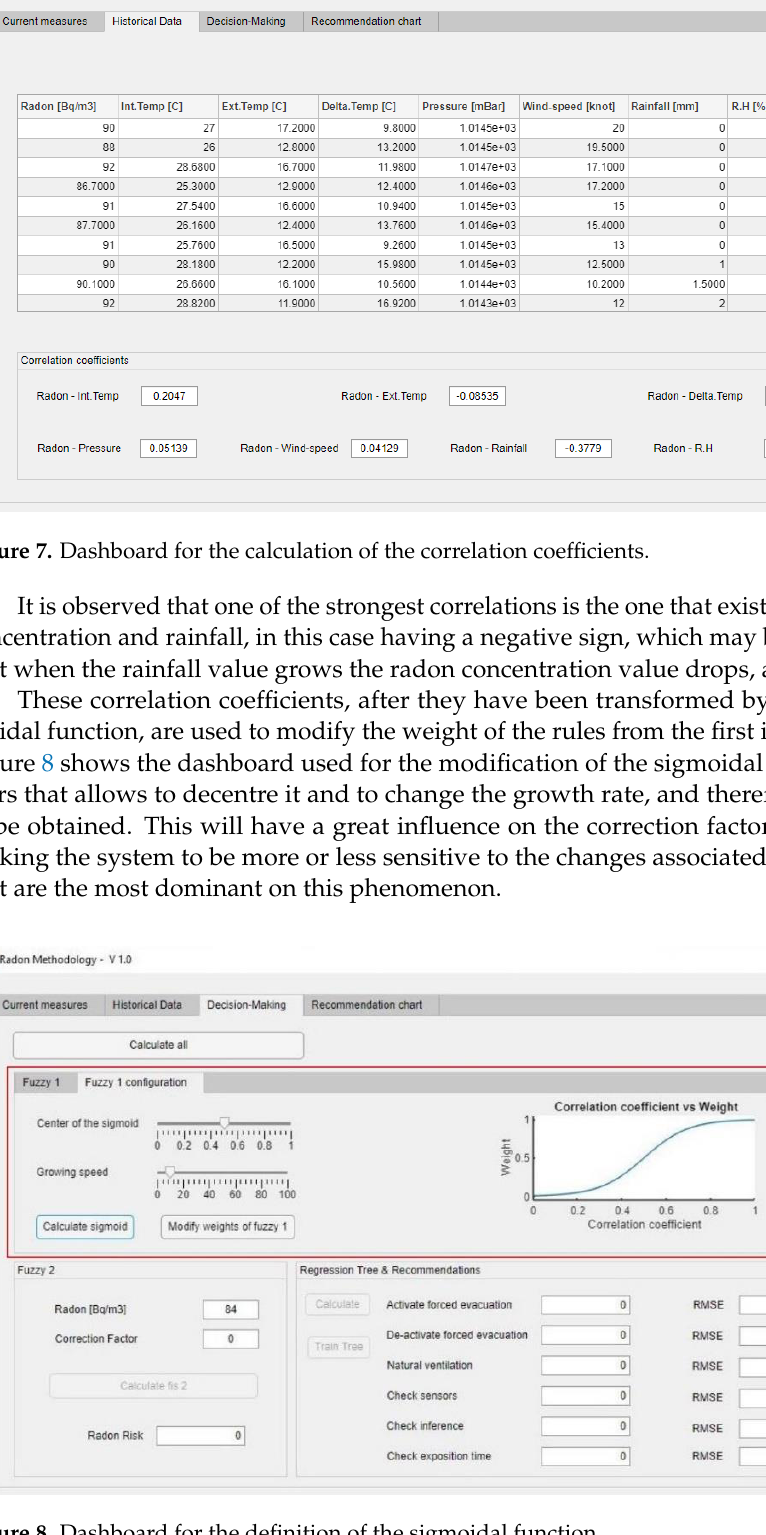
Figure 8. Dashboard for the definition of the sigmoidal function.